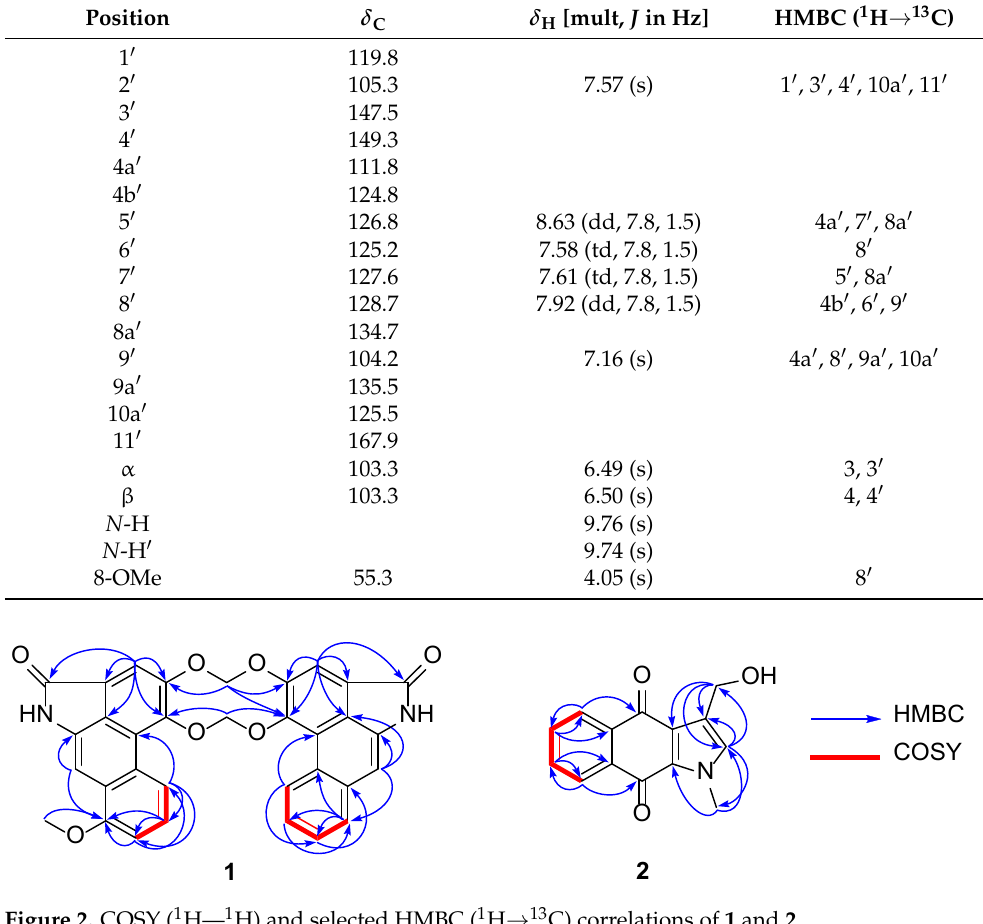
Figure 2. COSY ( 1 H— 1 H) and selected HMBC ( 1 H → 13 C) correlations of 1 and 2 .